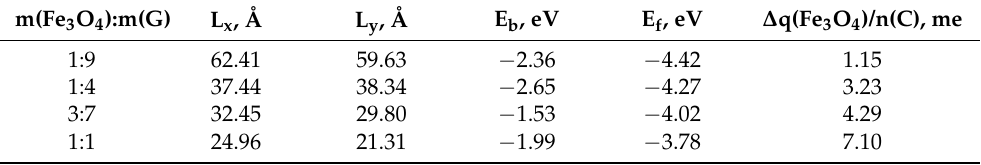
Table 1. Translation vectors L x and L y , bonding energy E b , Fermi level E f and relative value